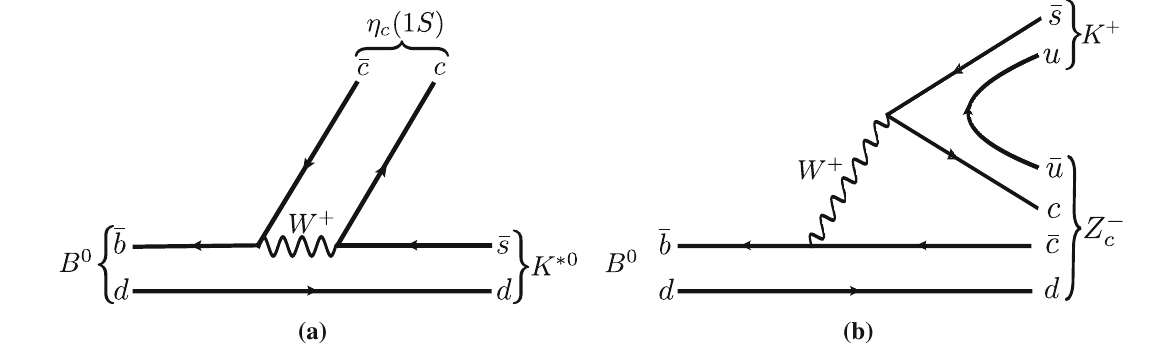
Fig. 1 Feynman diagrams for a B 0 → η c K ∗ 0 and b B 0 → Z − c K + decay